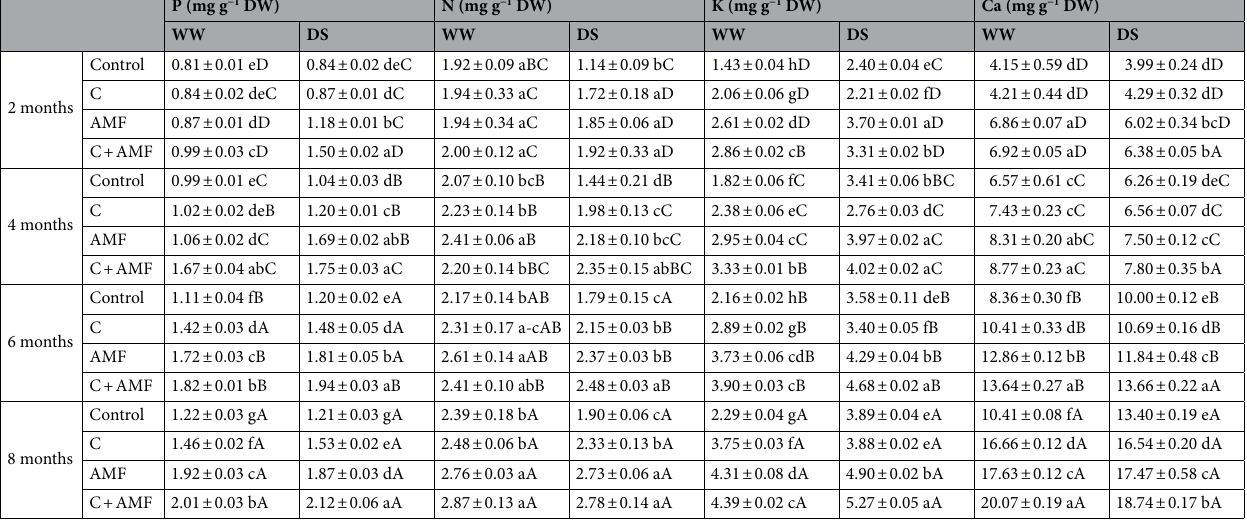
Table 3. Carob shoots mineral content subjected to different water status (WW: well-watered, DS: drought stress) and/or biofertilizers (C: compost, AMF: arbuscular mycorrhizal fungi, C + AMF: compost and